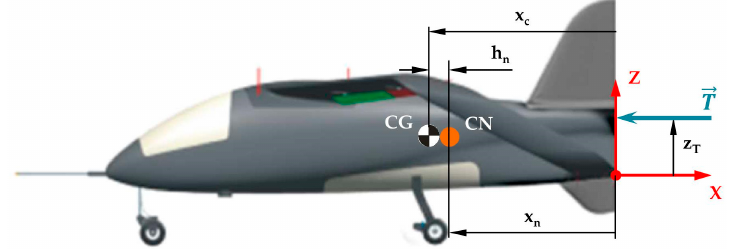
Figure 12. Center of gravity, neutral point position, and local axis system convention ( Ł ukasz Stefanek).